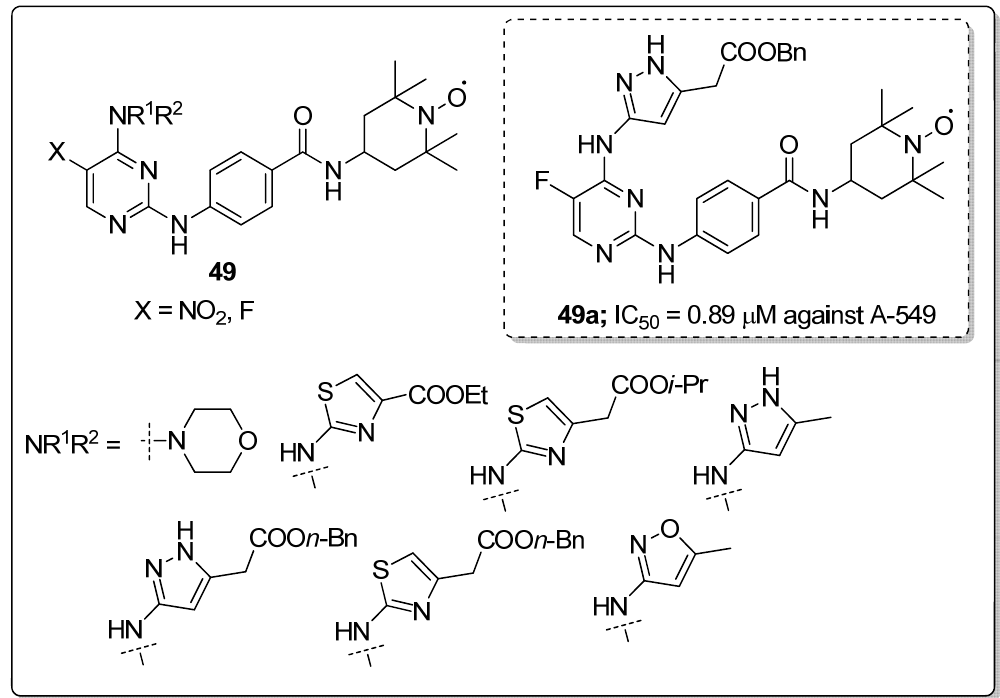
Figure 56. Antiproliferative activity of the most potent pyrimidine-linked nitroxide derivative 49a .